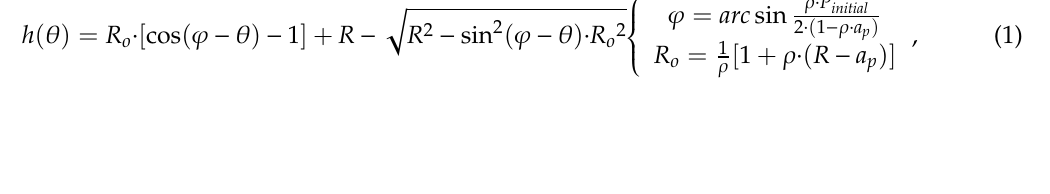
Figure 4. Sketch map of contour height.